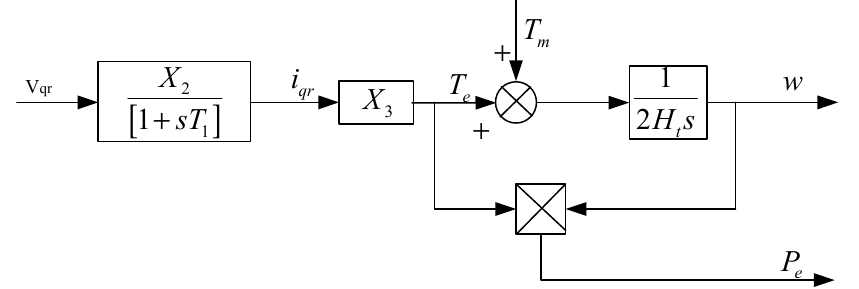
Figure 1. Simplified model of a DFIG-based wind turbine.